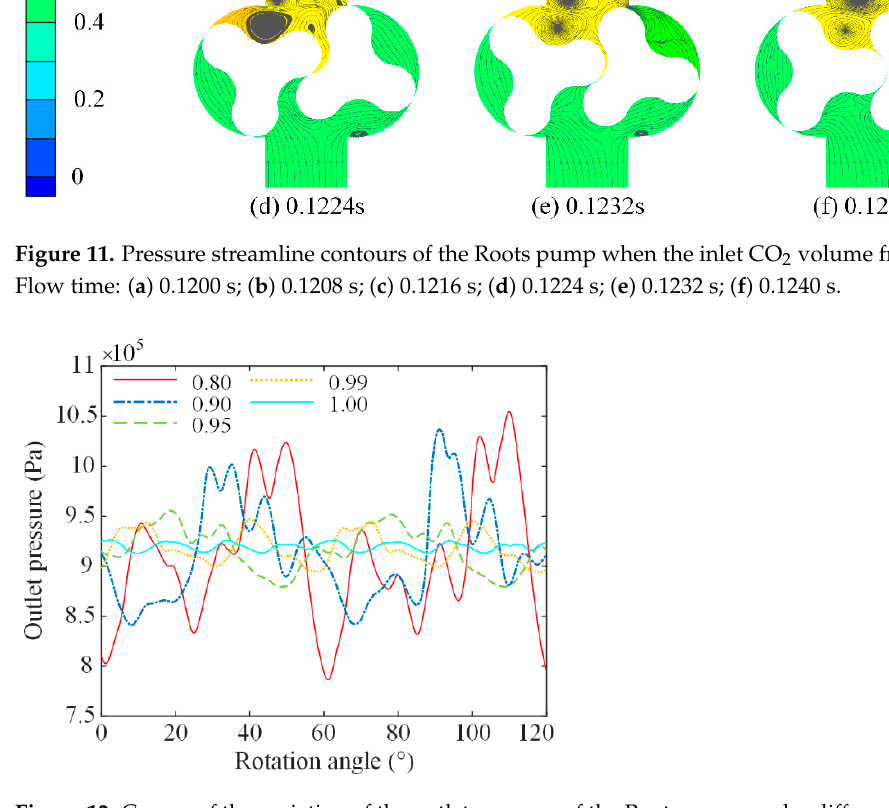
Figure 12. Curves of the variation of the outlet pressure of the Roots pump under different inlet CO 2 volume fractions.